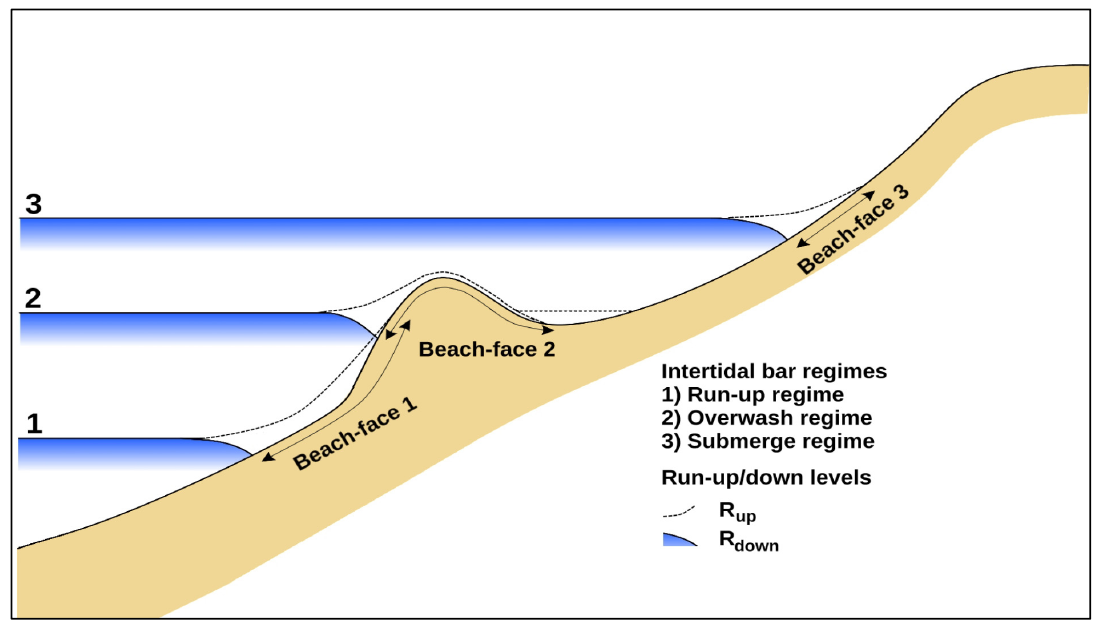
Figure 17 . Overview of the intertidal bar regimes . Figure 17. Overview of the intertidal bar